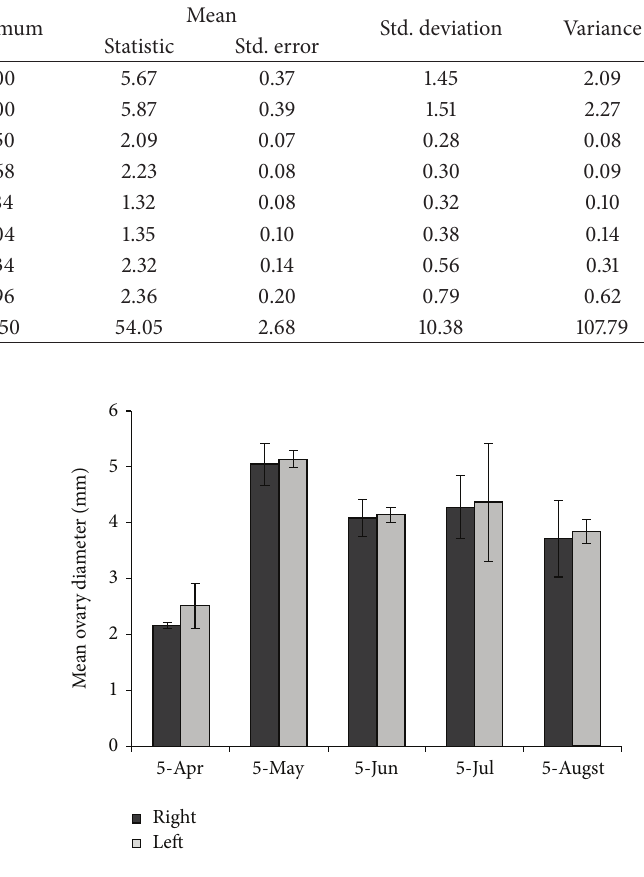
Figure 6: The mean ovary diameter of Teratoscincus bedriagai